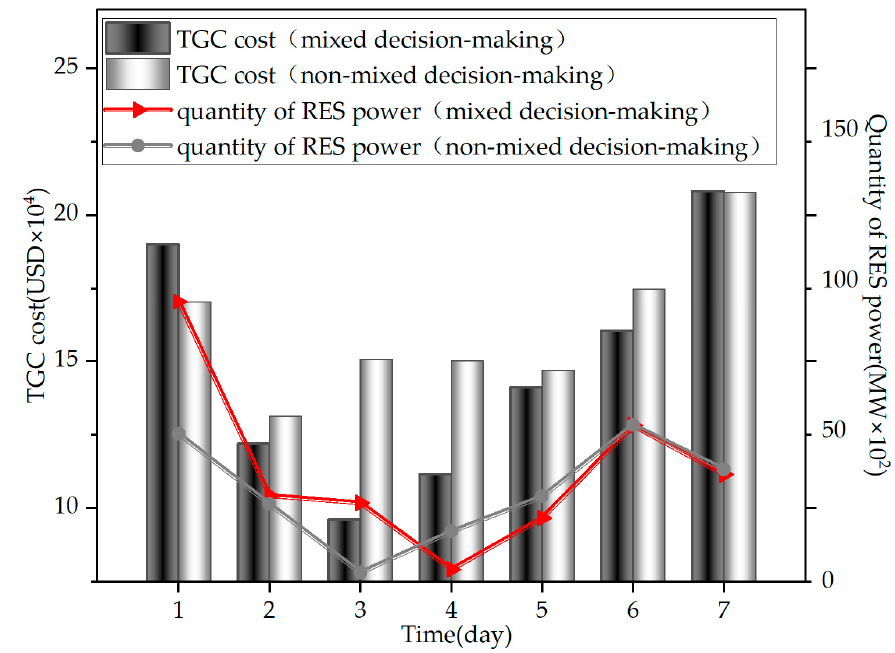
Figure 5. The cost of TGCs for the electricity sales company and the electricity purchase of RES.